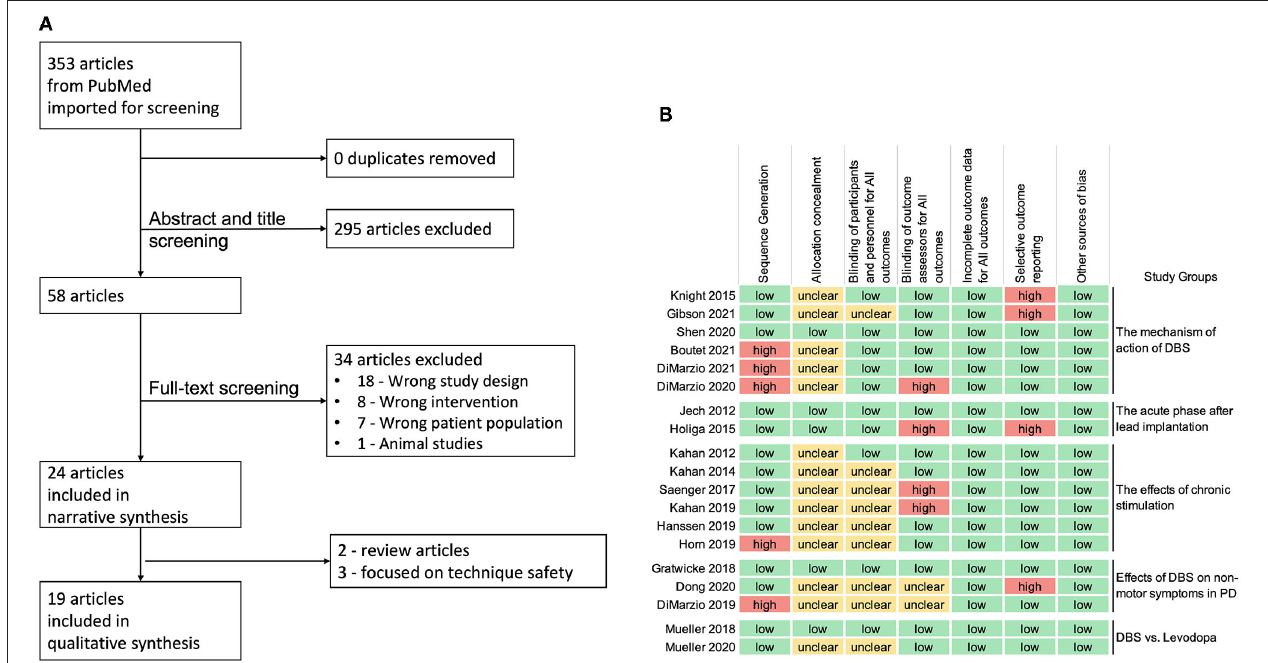
FIGURE 1 | (A) Preferred reporting items for systematic reviews and meta-analyses (PRISMA) flowchart. (B) Review authors’ judgments about each risk of bias domain for the 19 articles included in qualitative synthesis, following the Cochrane guidelines (high-risk in red, low-risk in green, and unclear risk of bias in yellow).